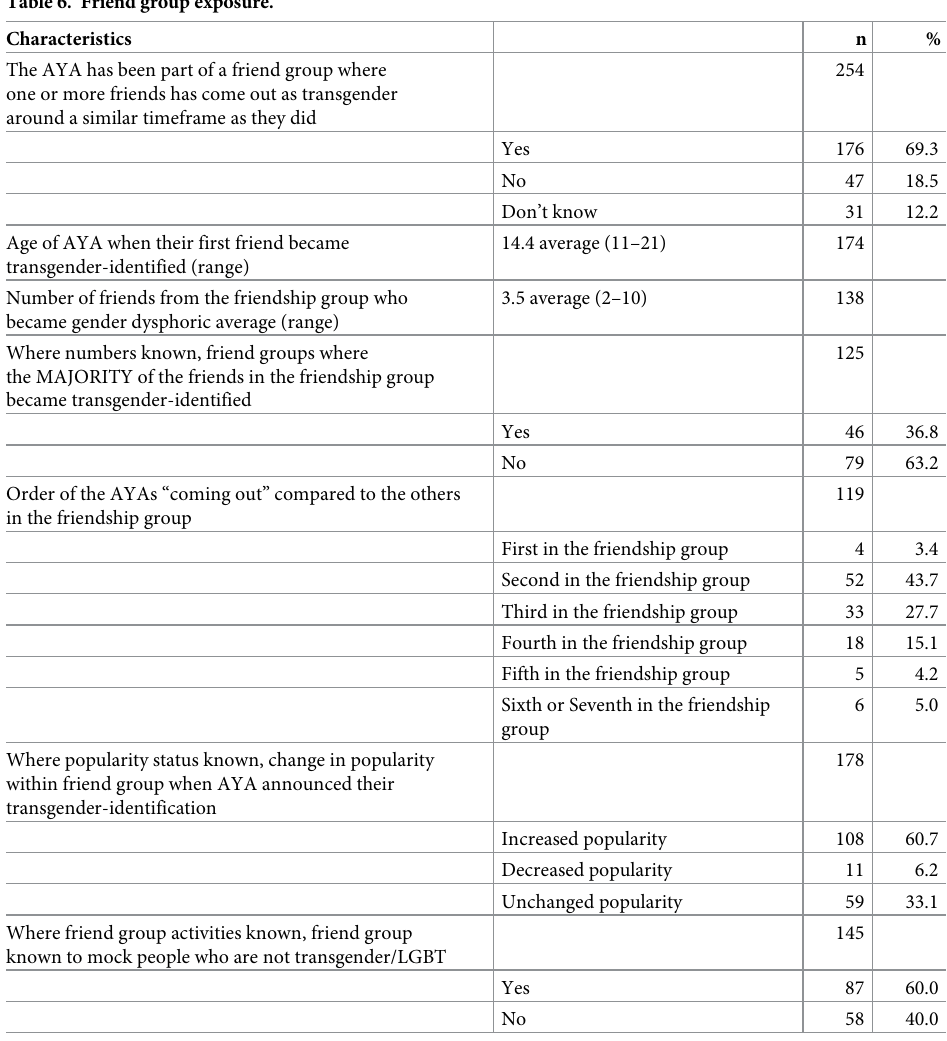
Table 6. Friend group exposure. Characteristics n